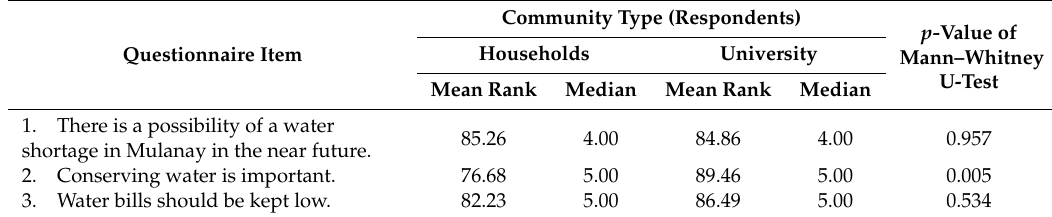
Table 4. Comparisons of opinions on water-related issues in Mulanay by group type.